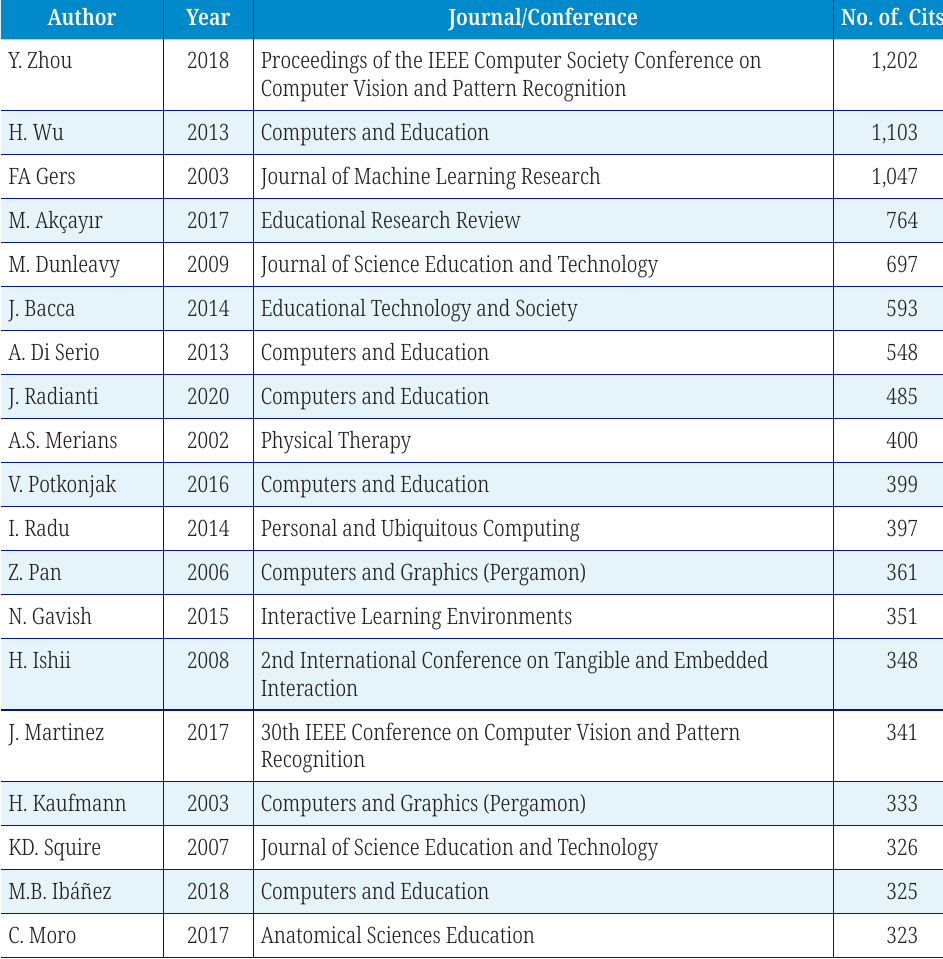
Table 5. Top 20 authors with most citations in AR/VR for